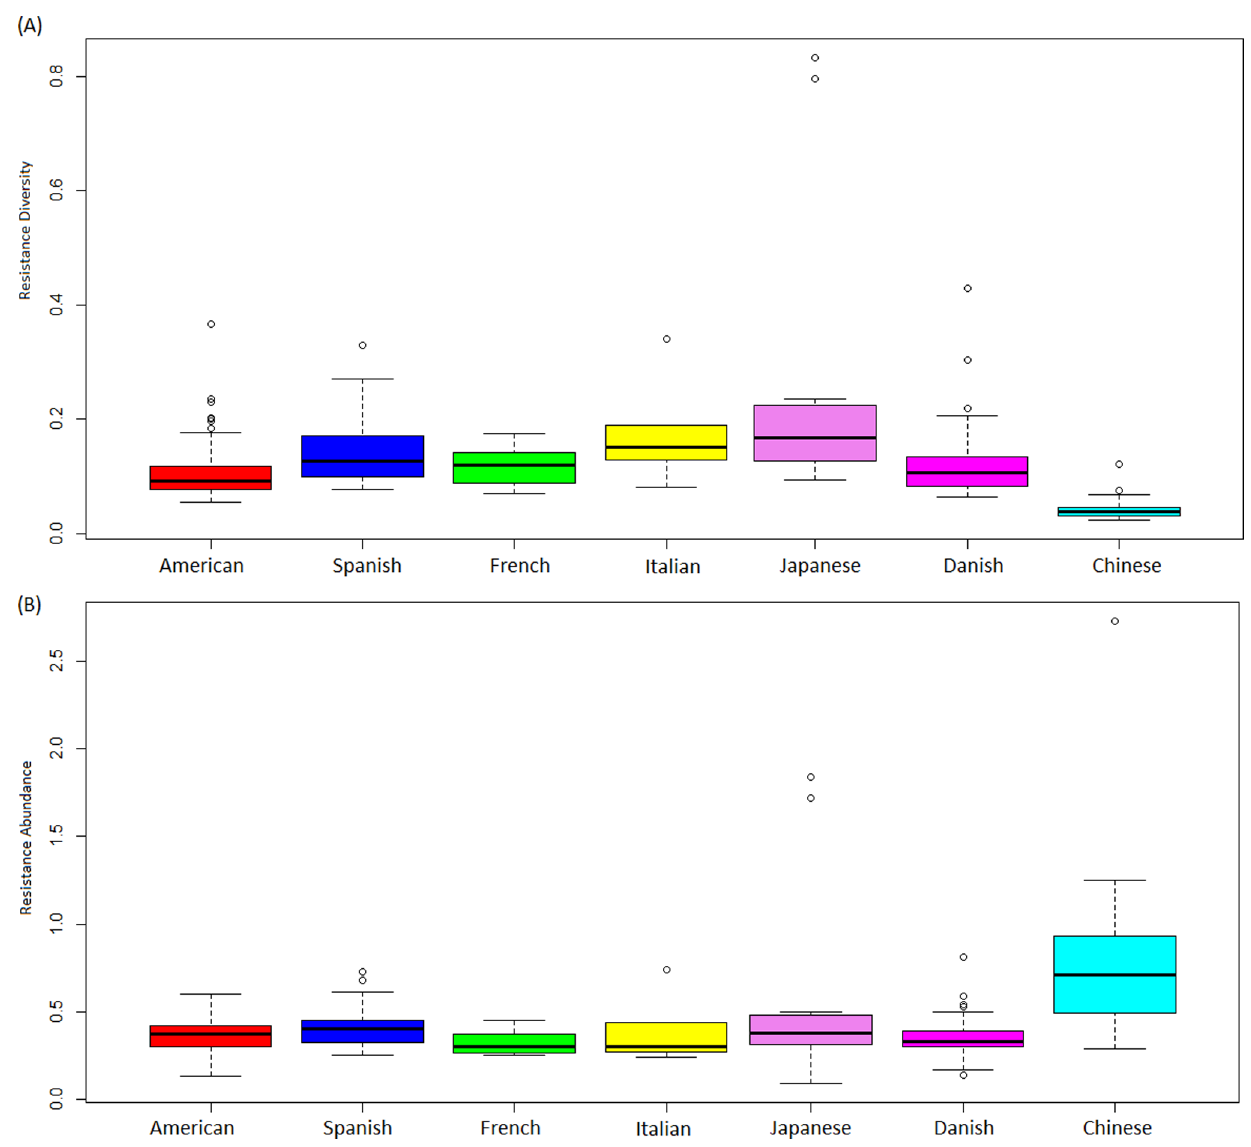
Figure 3. Diversity and Abundance of antibiotic resistance genes across nationalities. Diversity of antibiotic resistance genes across nationalities are shown in (A) and, the Abundances of antibiotic resistance genes, in the gut of individuals from various nationalities are shown in (B). Details of the gut microbiomes obtained from individuals belonging to various nationalities (indicated in the figure) are provided in Table S1.